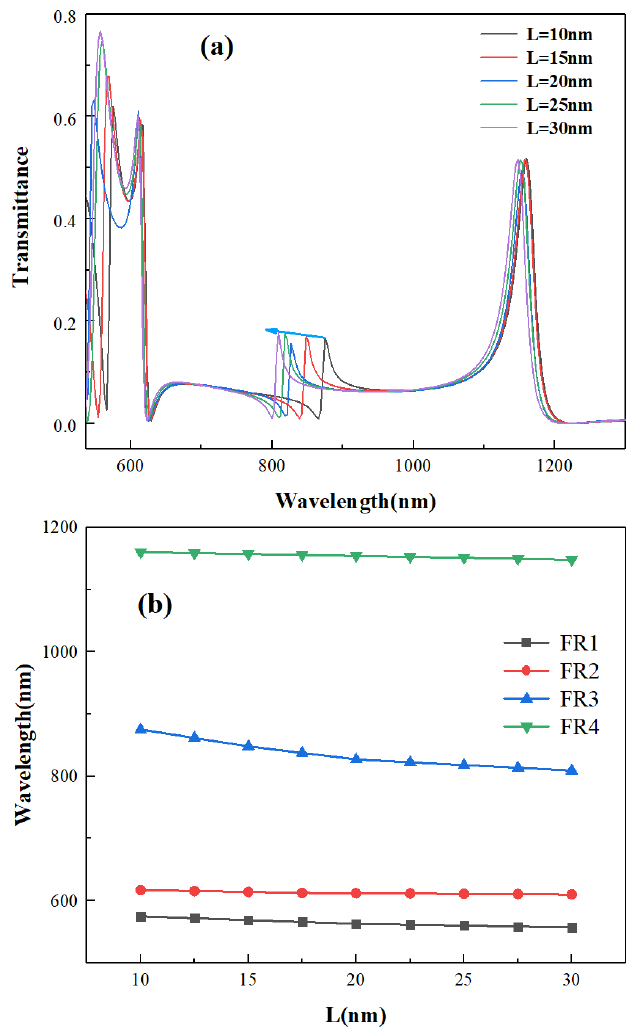
Figure 6. ( a ) Transmission spectra of the structures with different CSRRC opening widths. ( b ) The relationship between the resonance wavelength and the CSRRC opening widths.